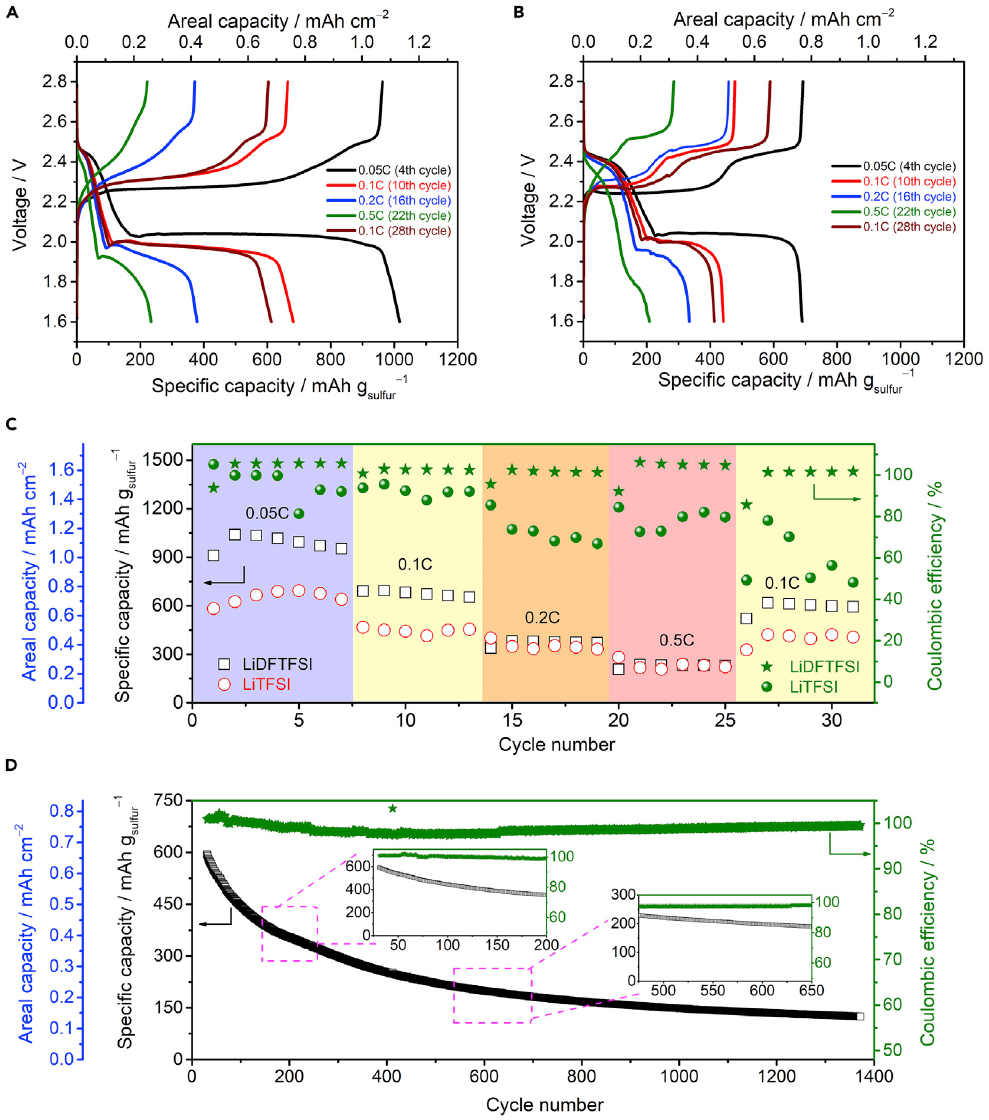
Figure 2. Electrochemical performance of designer anion. ( A , B ) Discharge/charge profiles of the Li-S cells using LiX/PEO (X = DFTFSI [ A ] or TFSI [ B ]) electrolytes at 70 °C. ( C ) Rate capability of the Li-S cells with LiX/PEO (X = DFTFSI or TFSI) electrolytes. ( D ) Long-term cycling stability of the Li-S cells using LiDFTFSI/PEO electrolytes at a discharge and charge rate of 0.1/0.1C (after C-rate test). Reproduced with permission from ref. [16]. Copyright 2019 Elsevier.